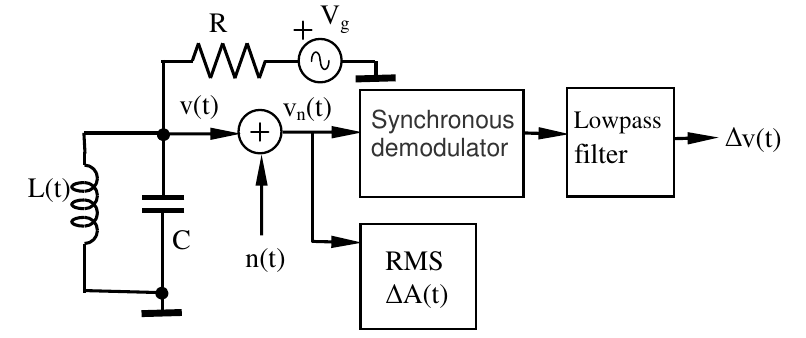
Figure 4. Block scheme of an amplitude